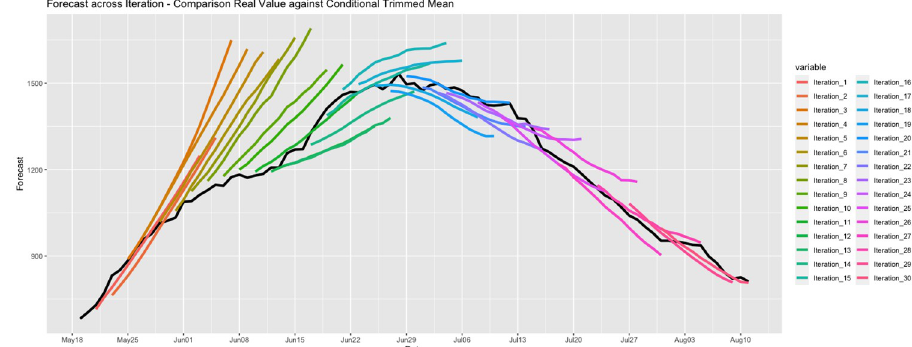
Fig 4. Forecasting iterations—Accuracy performance